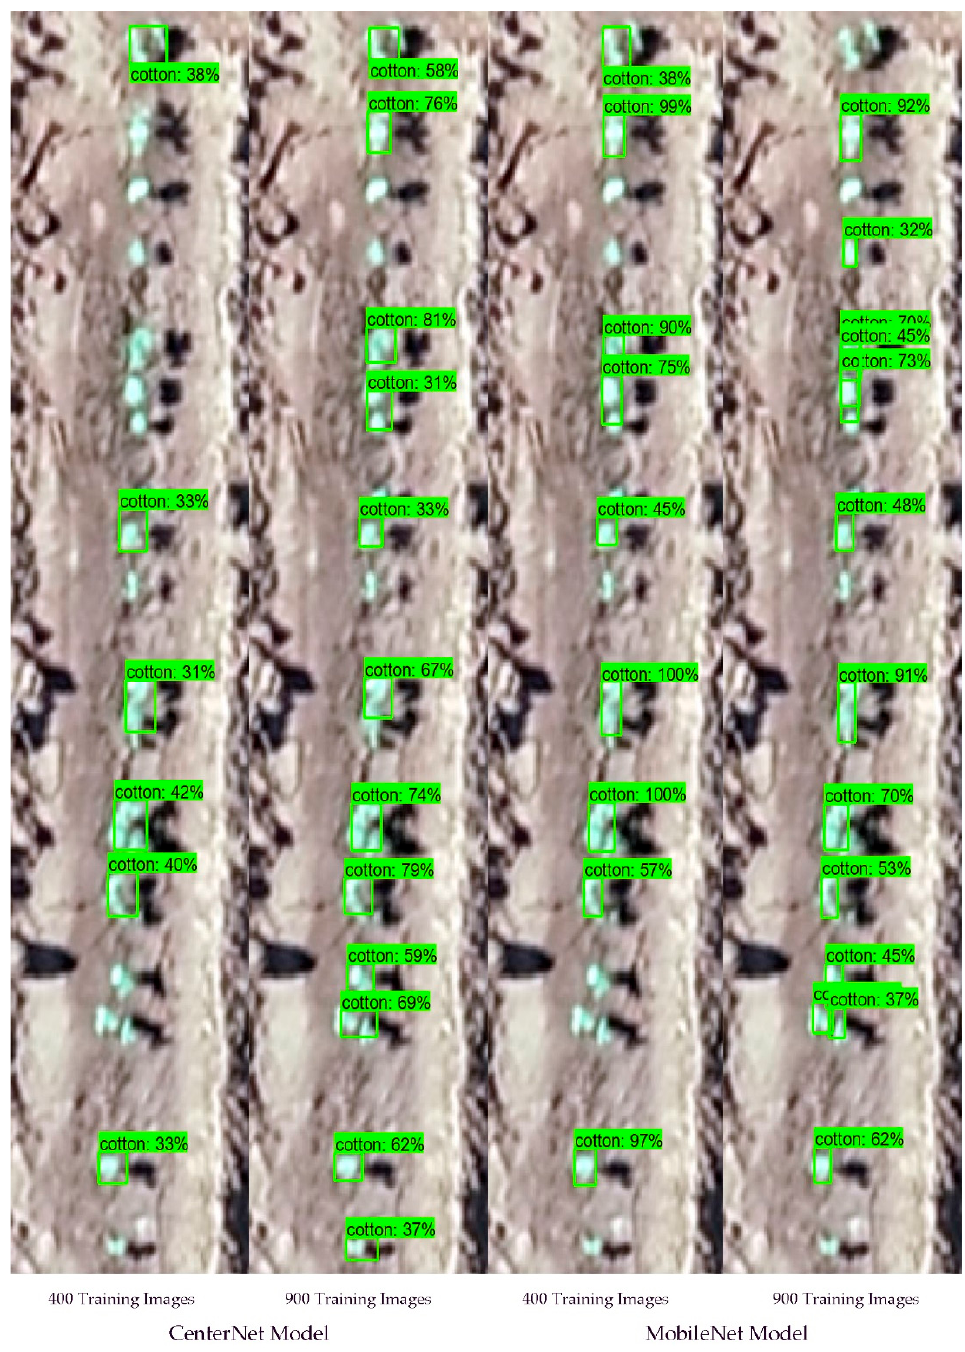
Figure 3. Examples of cotton plant detection and counting results using an unmanned aerial system image acquired on 8 June 2020. Percentage labels around bounding boxes represent F1-scores for detected cotton plants.